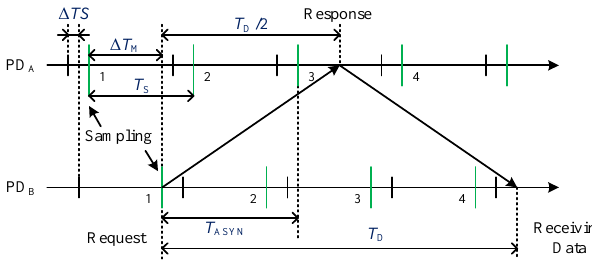
Figure 5. The communication process of two protection devices (PDs).